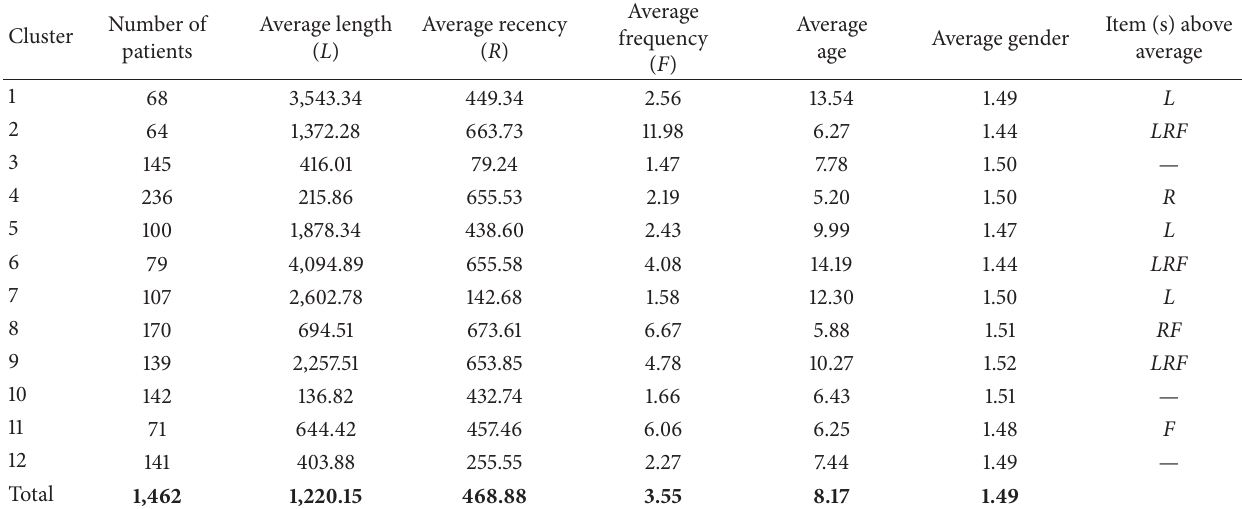
Table 4: Descriptive statistics of twelve clusters based on SOM technique.